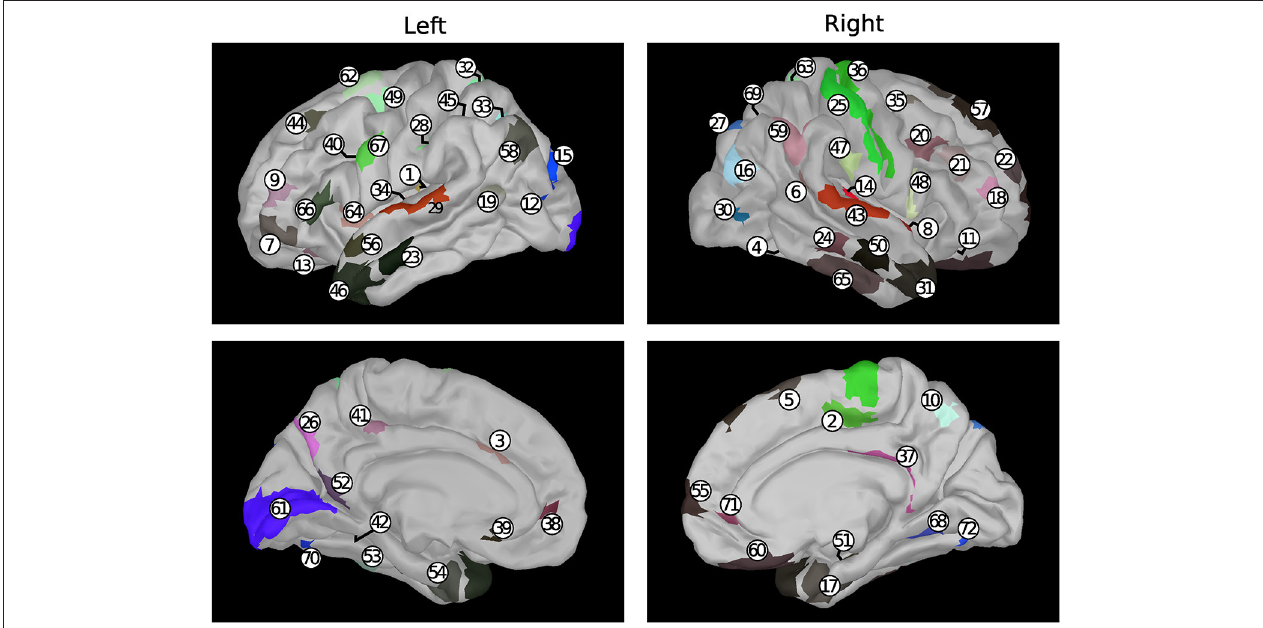
FIGURE 1 | Position, represented on a default anatomy, of the areas listed in Table 1 . Colors are related to the functional group of the corresponding area according to the reference atlas (Glasser et al., 2016) considered in the present work.